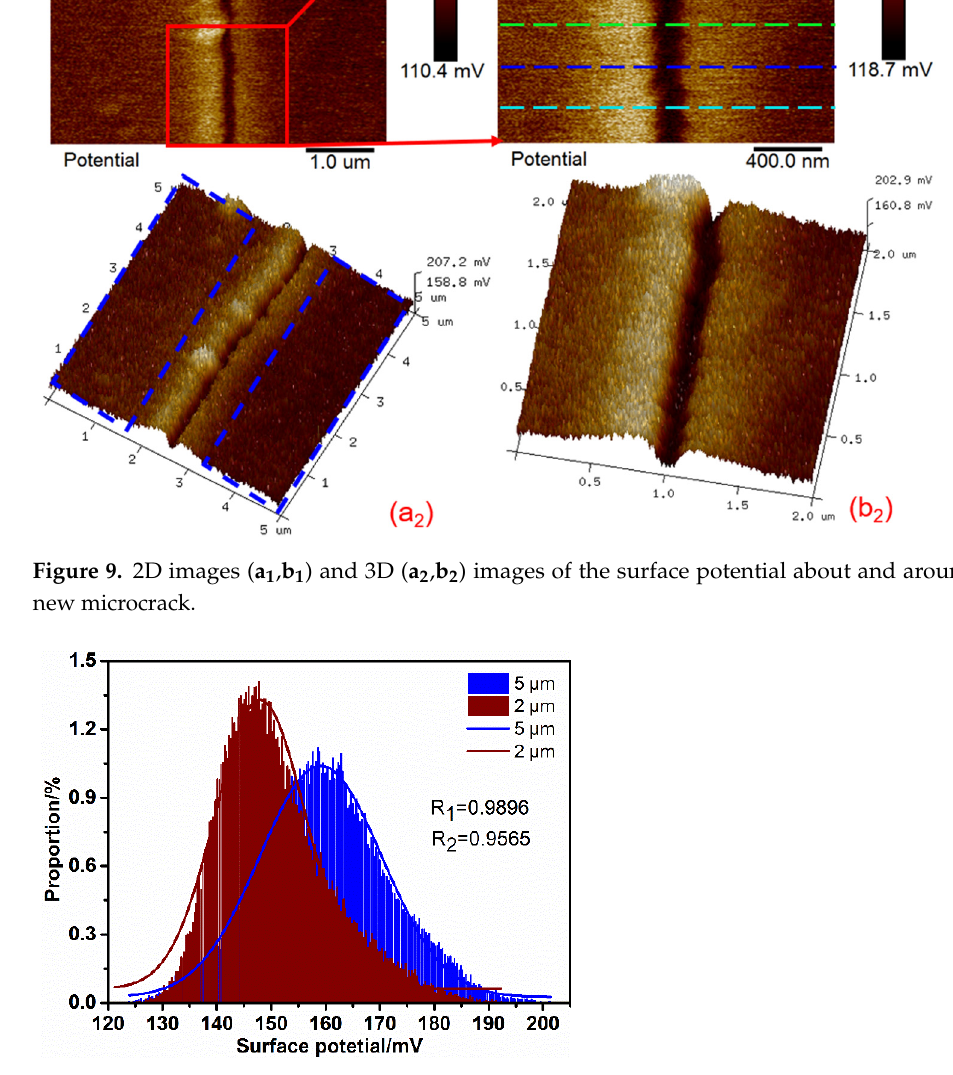
Figure 10. Proportion distribution of surface potential and fitting curve in 2 μ m × 2 μ m and 5 μ m × 5 μ m.